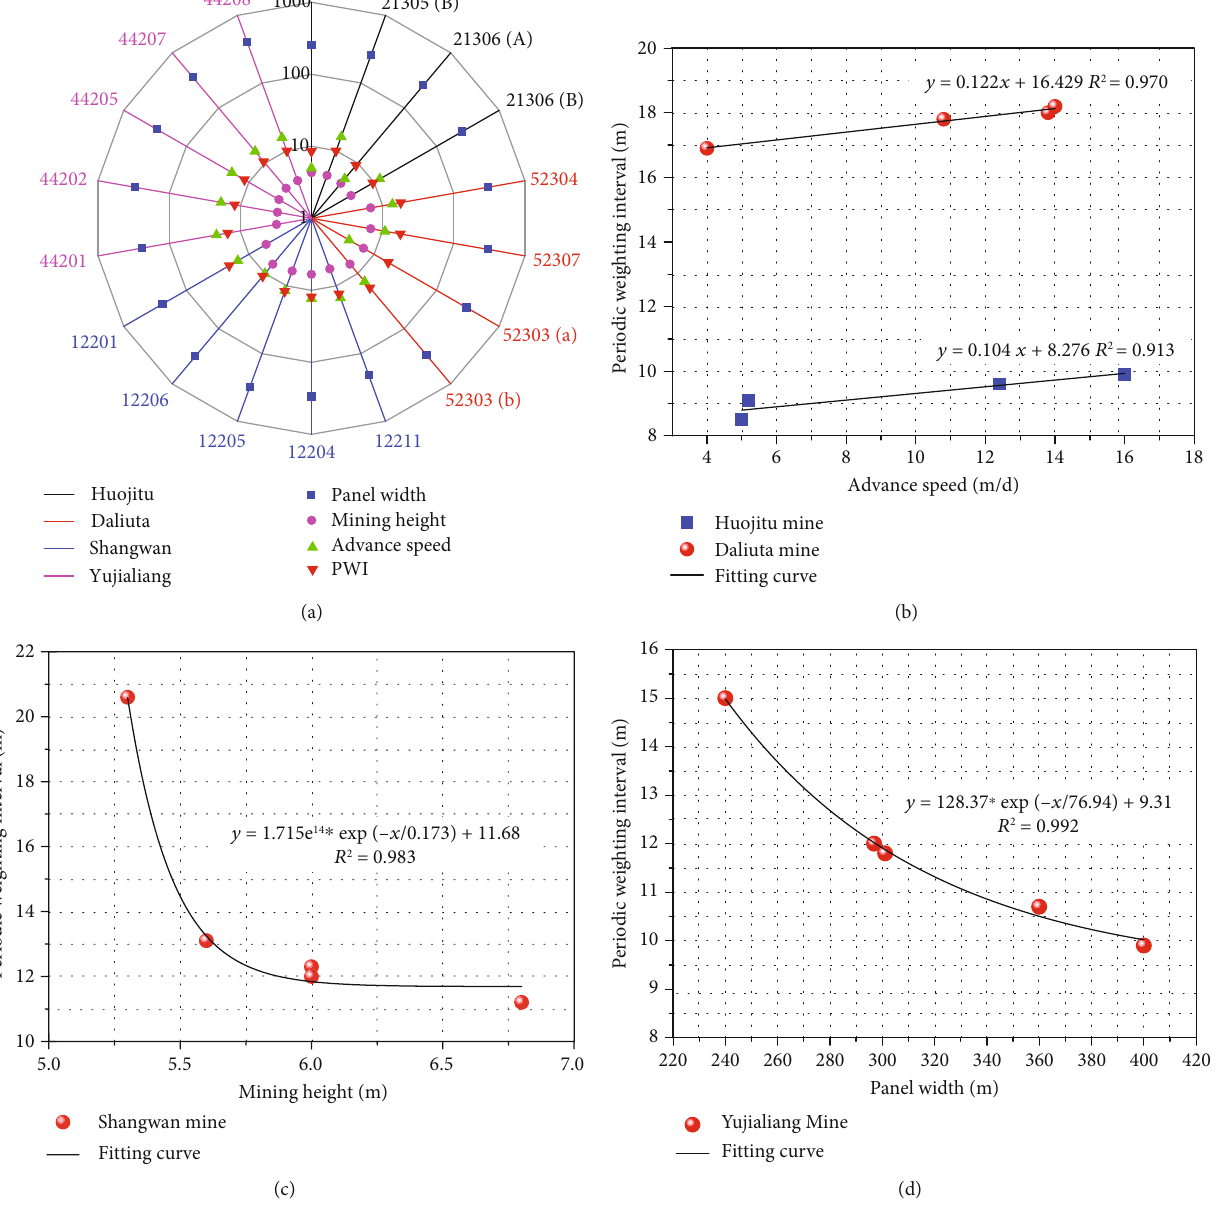
Figure 1: Analysis of the relationship between the mining parameters and PWI. (a) The statistics of the high-intensity mining parameters and the PWI; (b – d) the relationship between the advancing speed, mining height, and panel width,